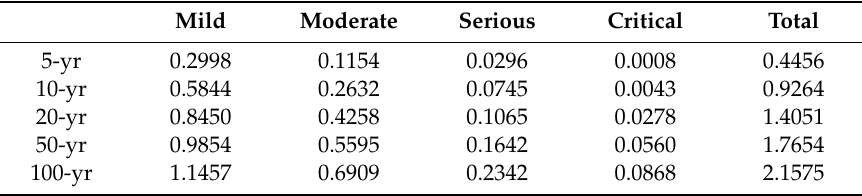
Table 2. Size of a ff ected building areas in di ff erent rainfall return periods (km 2 ). Table 2. Size of affected building areas in different rainfall return periods (km 2 ). Mild